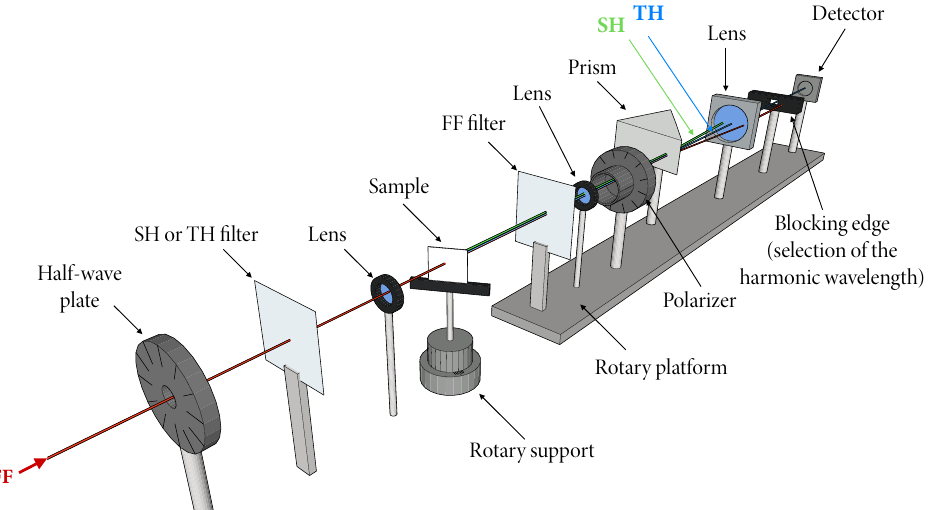
Fig. 1. Experimental set-up developed for measuring SH and TH signals from 20nm and 70nm-thick Au nanolayers. The rotary support allows us to rotate the sample so that we can take measurements as a function of the angle of incidence. The detection system is mounted on a rotary platform so that measurements can be taken in transmission and in